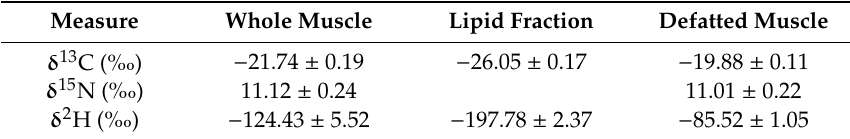
Table 3. Mean isotopic values of whole muscle, lipid fraction, and defatted muscle of nine sea bass from C4